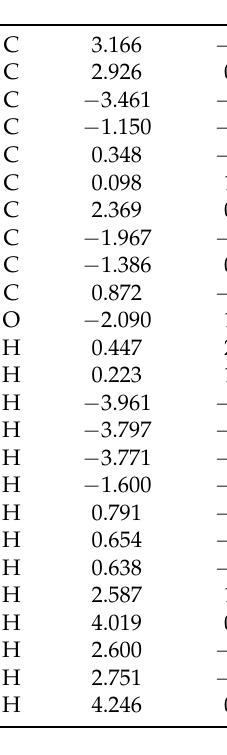
Table 2. Coordinates of the global minimum: (MP2/6-31++G(d,p), E(Eh) = −